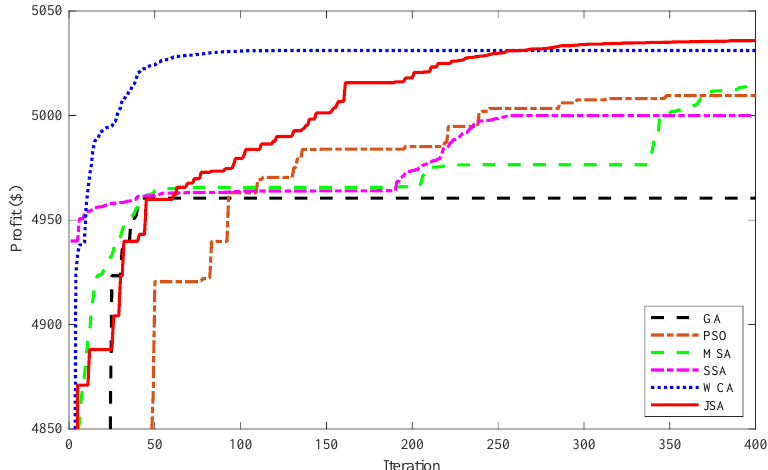
Figure 11. The process of finding the best profit implemented by applied algorithms for Case 3.